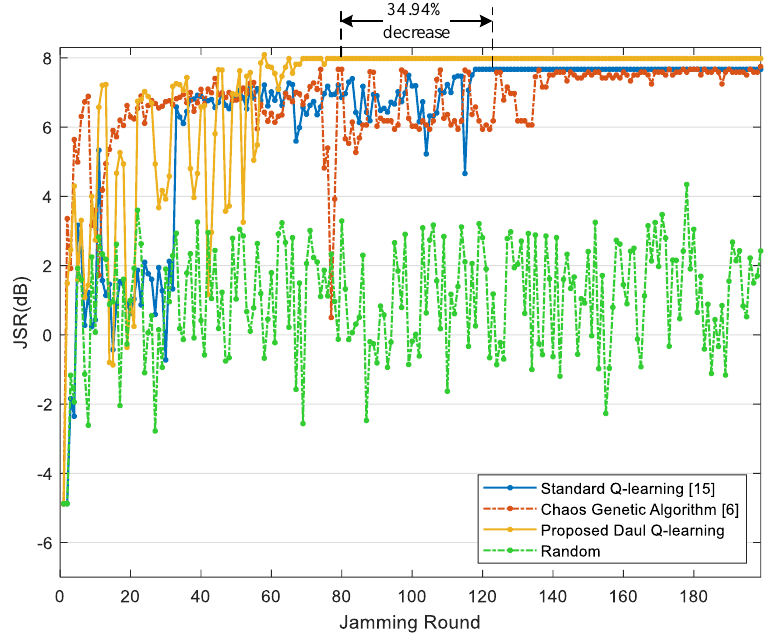
Figure 6. JSR comparison among different methods.